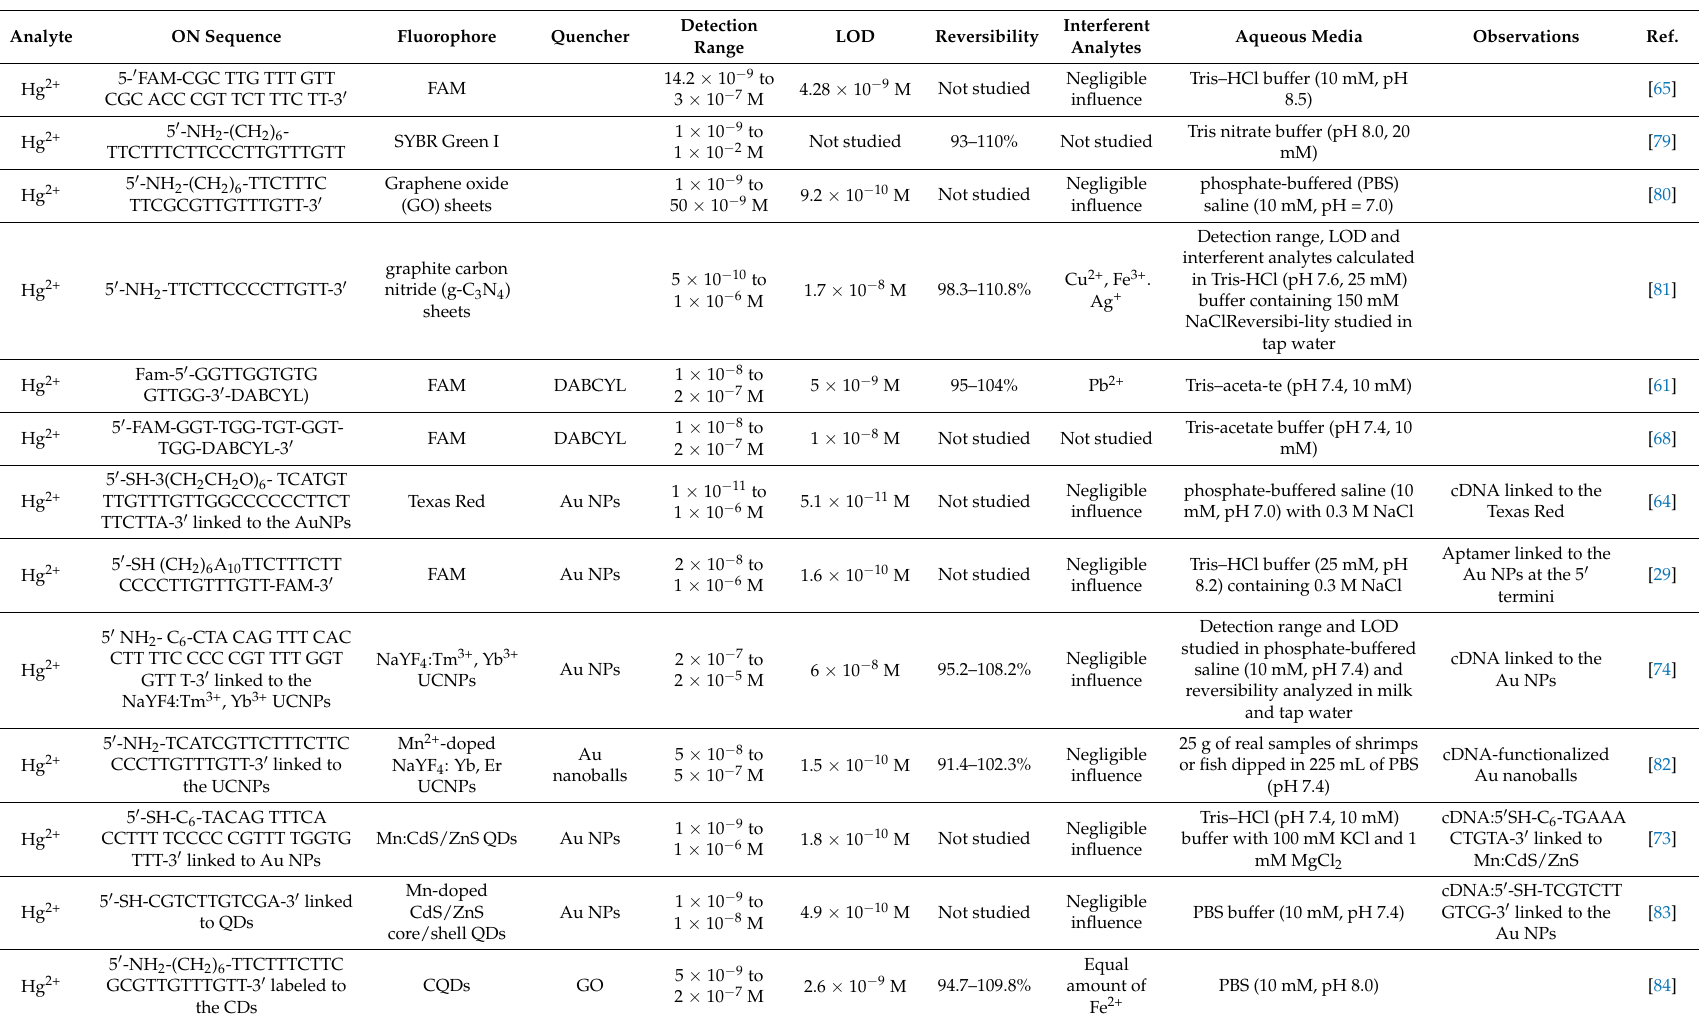
Table 1. Hg 2+ fluorescent sensors based on aptamer